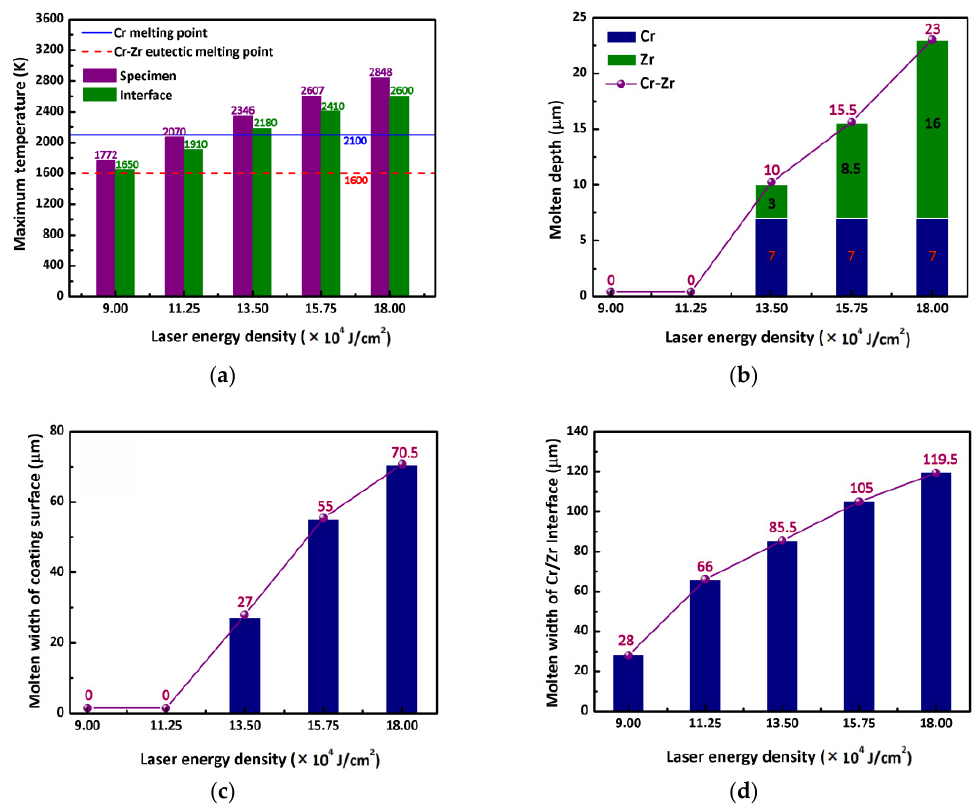
Figure 4. The relationship between the maximum temperature of the coating surface and Cr/Zr Figure 4. TherelationshipbetweenthemaximumtemperatureofthecoatingsurfaceandCr / Zrinterface( a ), interface ( a ), the molten depth of Cr coating and Zr substrate ( b ), the molten width of the coating themoltendepthofCrcoatingandZrsubstrate( b ),the molten width of the coating surface ( c ). The molten surface ( c ). the molten width of the Cr/Zr interface and laser energy density is obtained by laser width of the Cr / Zr interface and laser energy density is obtained by laser melting simulation ( d melting simulation( d ).